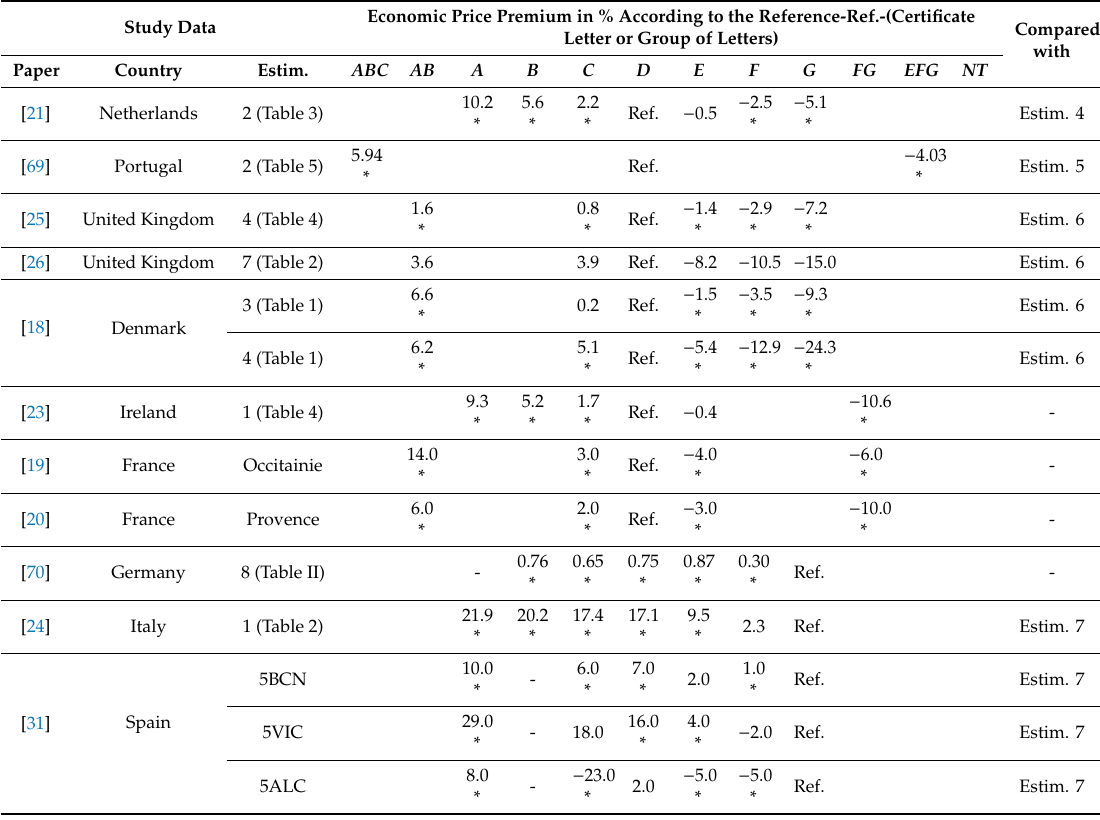
Table 6. Comparative of premiums in % from this study (estimations 4 to 9) with studies published in Europe on energy